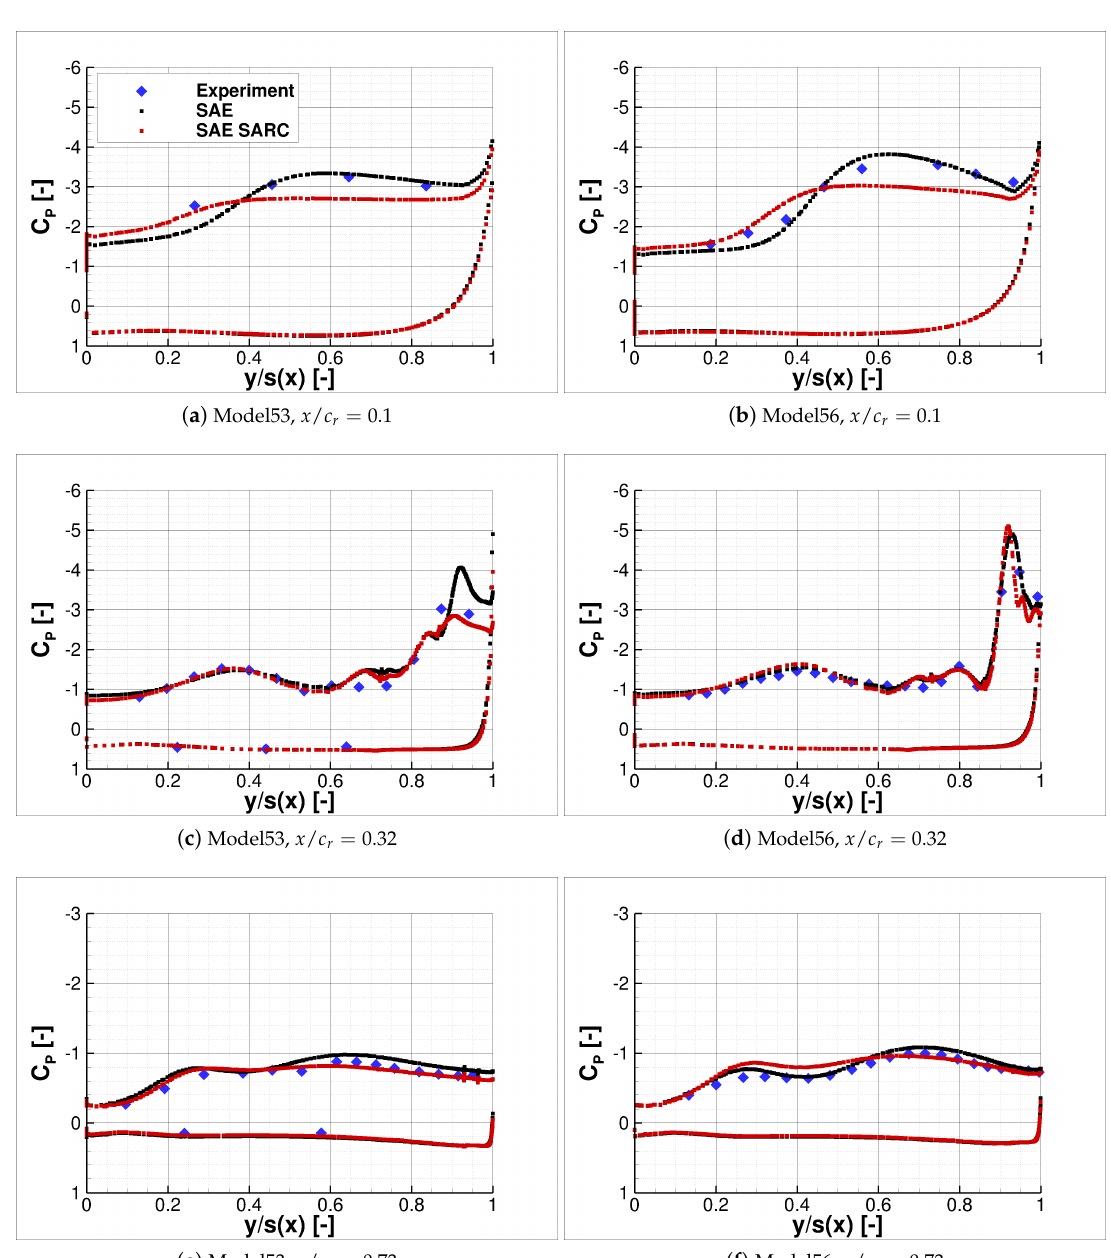
Figure 16. Surface pressure coefficient distribution C p against local semi-span y / s at α = 25 ◦ for the Model53 and